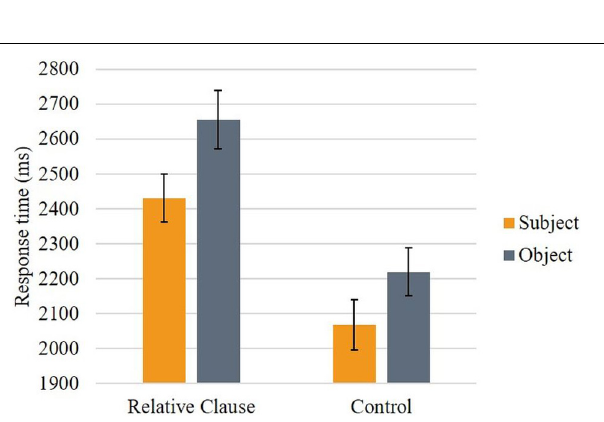
FIGURE 4 | Mean response time by condition (bars represent 95% confidence interval).